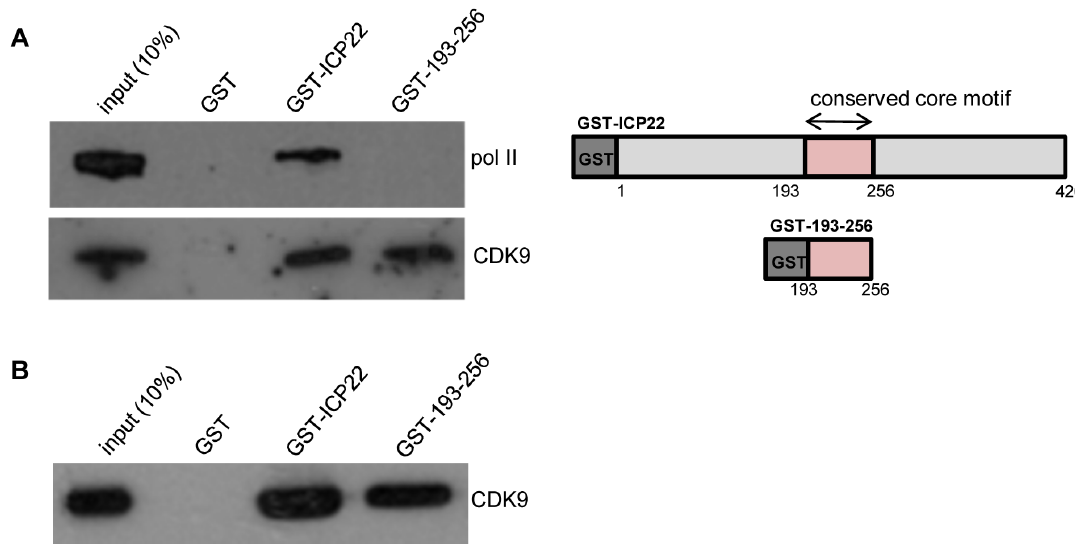
Figure 5. ICP22 interacts with pol II and CDK9. ( A ) GST-mediated pull-down from HeLa nuclear extract with the recombinant proteins indicated at the top, followed by western blot analysis using anti-pol II and anti-CDK9 antibodies. On the right, a diagram of full-length ICP22 and 193–256 shows the position of the alphaherpesvirus conserved core motif and the GST tags. ( B ) GST-mediated pull-down of recombinant P-TEFb by the recombinant proteins indicated at the top followed by western blot analysis using an anti-CDK9